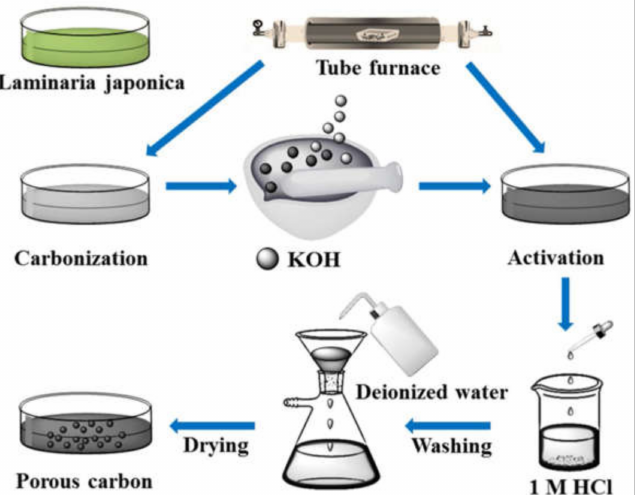
Figure 11. The schematic illustration for the synthesis of porous carbons derived from Laminaria japonica. Reproduced with permission from [190]. Elsevier, 2020.